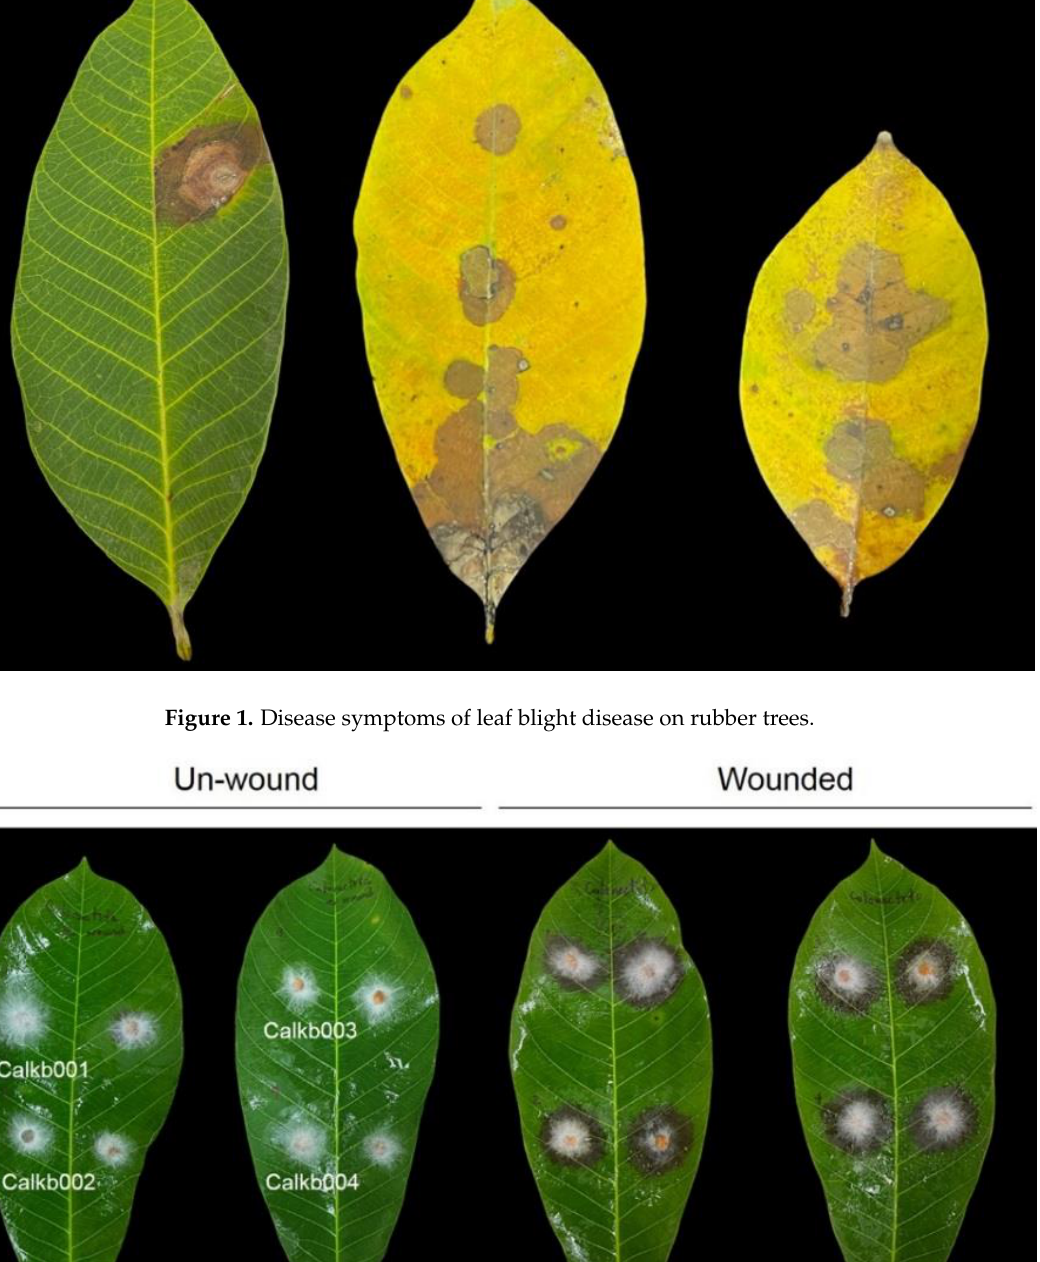
Figure 1. Disease symptoms of leaf blight disease on rubber trees.